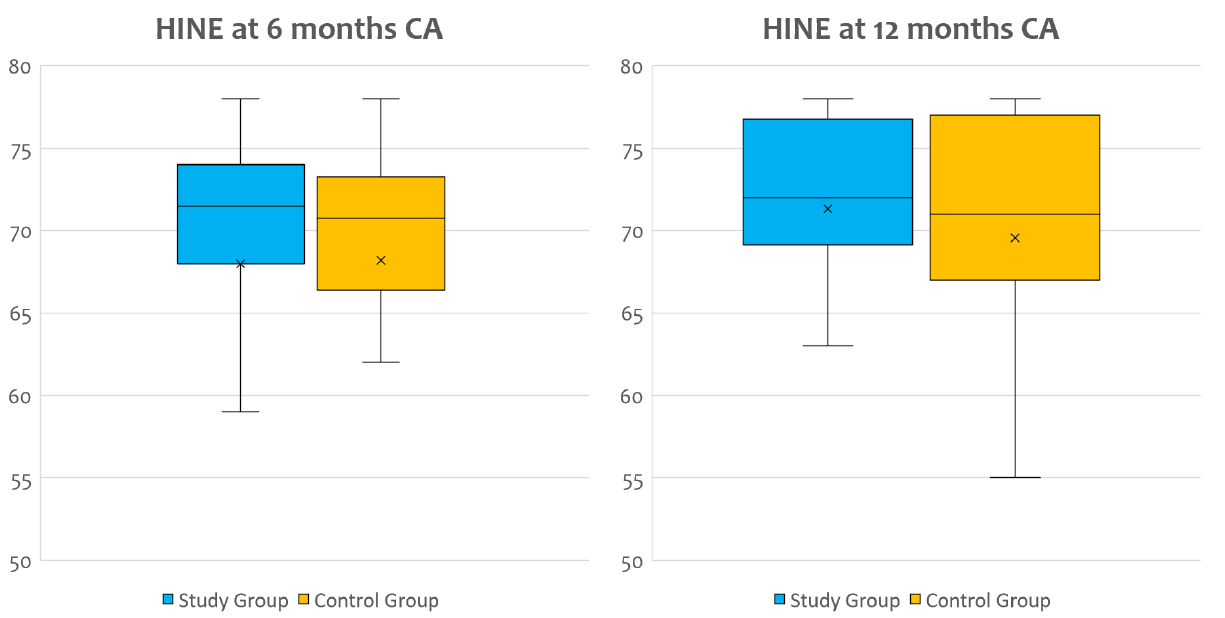
Table 4. Long-term neurodevelopmental outcomes in the two groups at 24 months CA. Study Group (n = 37)